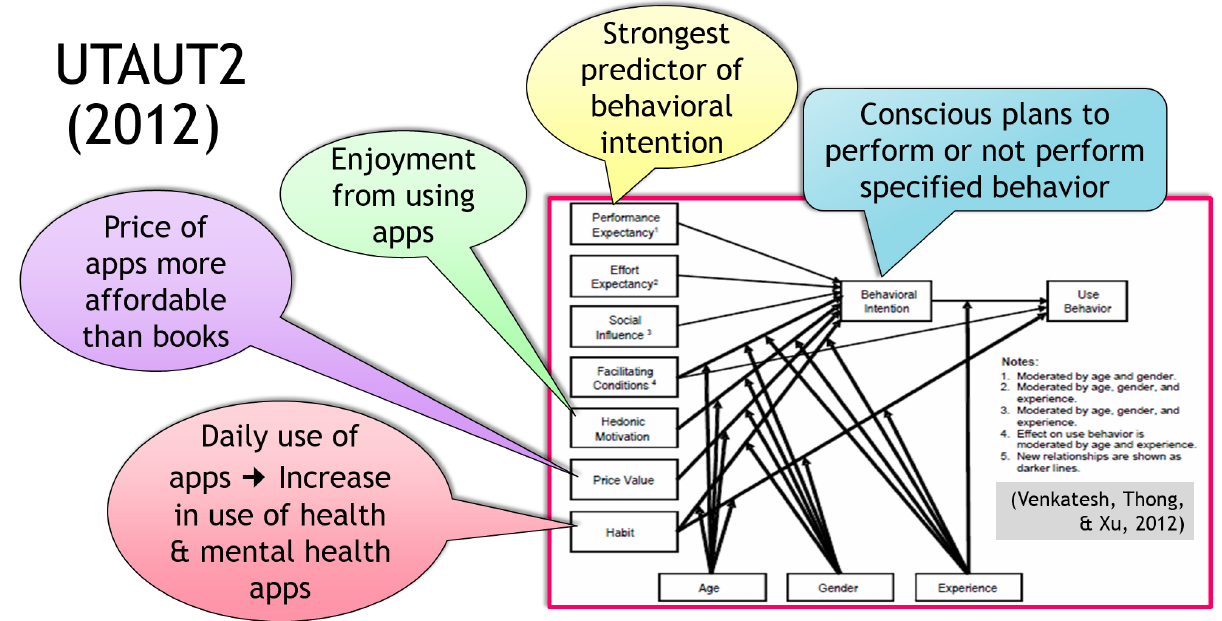
Figure 2. Potential for diffusion of mental health mobile apps based on the unified theory of use & acceptance 2 (UTAUT2). © 2012, Regents of the University of Minnesota, used with